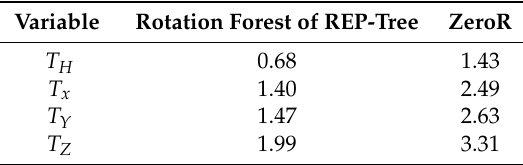
Table 7. Average of the absolute error for the best method, and the error that would be committed if the average of T H , T x , T y , T z were always predicted (i.e., if ZeroR is used). Variable Rotation Forest of REP-Tree ZeroR T H